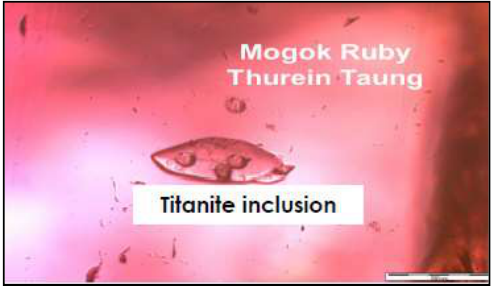
Figure 7. Thurein Taung ruby crystal hosting composite titanite inclusion 0.025 mm in length. The small circular structures represent ablation pits from initial analyses. Photo; Khin Zaw.